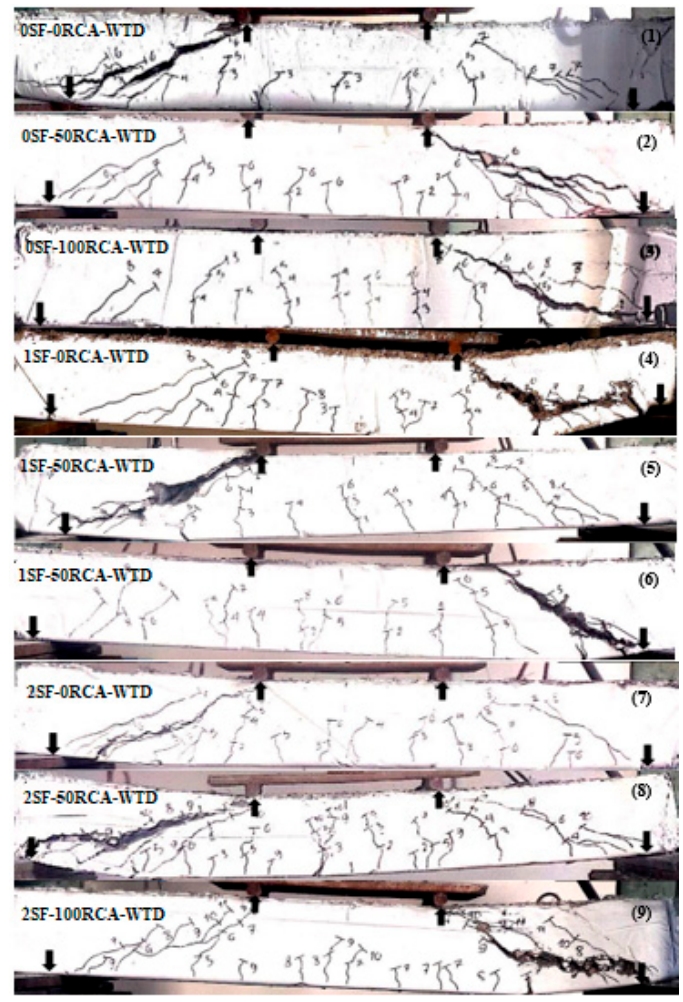
Figure 15. Failure and crack propagation of the specimens without a stirrup. Appl. Sci. 2020 , 10 , x FOR PEER REVIEW